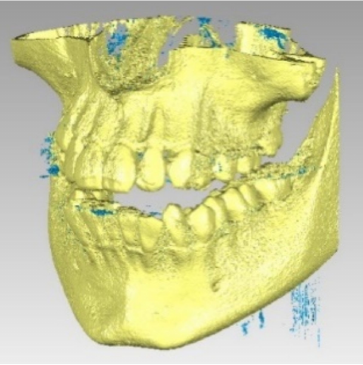
Figure 8. The primary bone and dental geometry of the patient studied in the Geomagic software.